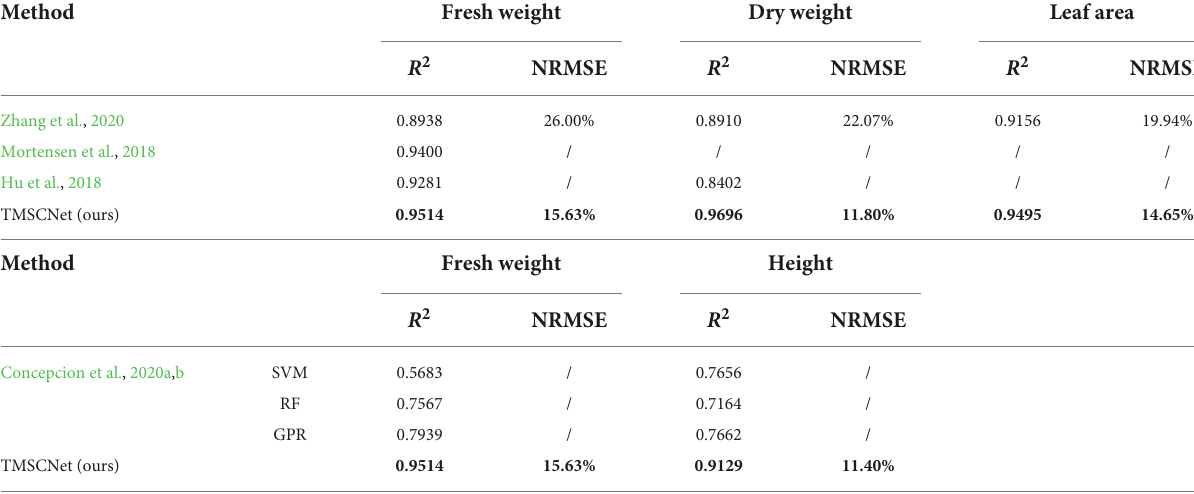
TABLE 10 Results of the estimated lettuce traits by previous studies and